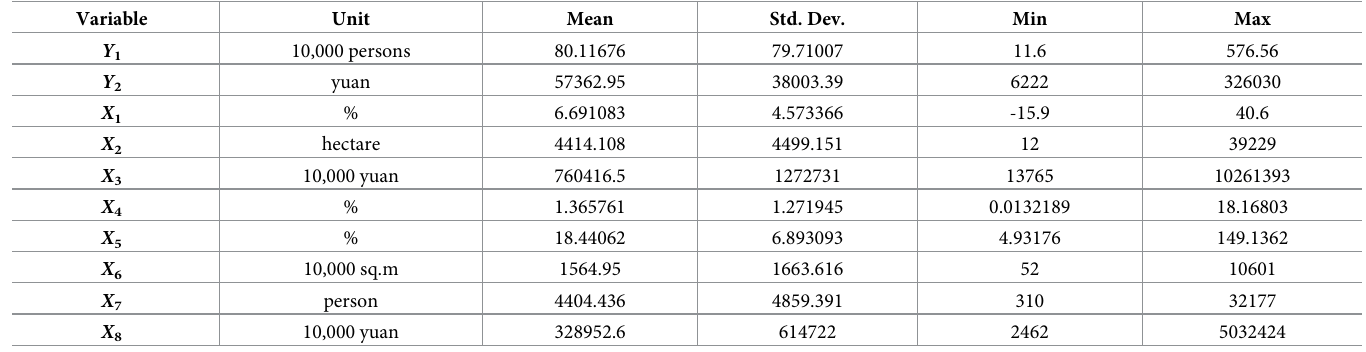
Table 5. Descriptive statistics of